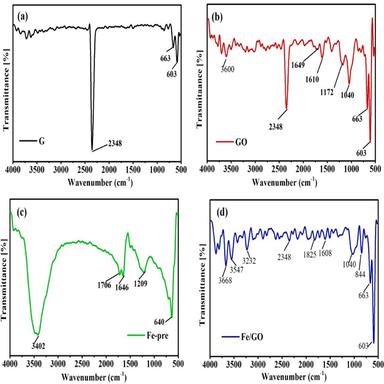
FTIR Spectra for (a) Graphite (G), (b) Graphene Oxide (GO), (c) Precursor Iron(III) Complex, and (d) Fe-GO Nanocomposite.